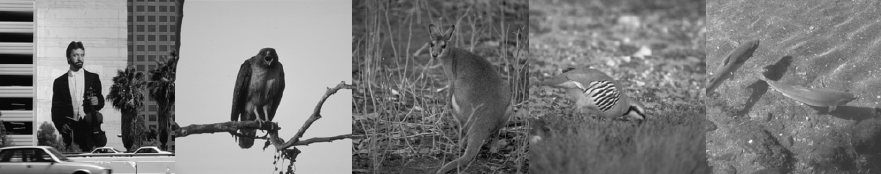
Figure 2. Thumbnails of